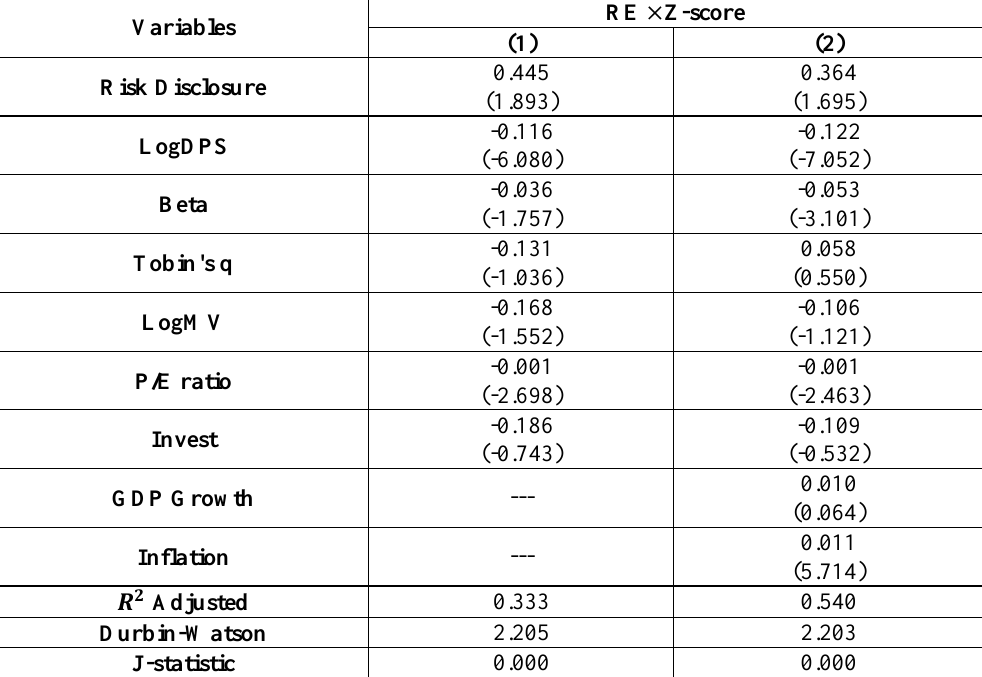
Table 7. Estimation of a regression